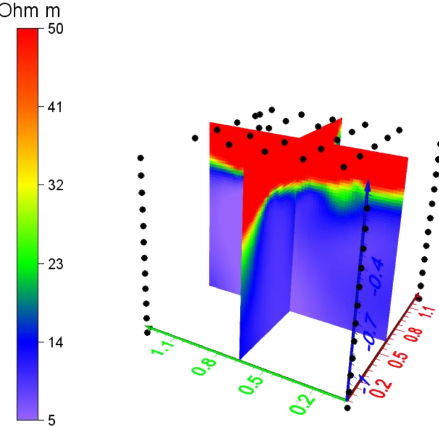
Figure 4. Cross sections of the ERT cube corresponding to the background acquisition of 2 October 2013, 11:00LT. Note the very strong difference in electrical resistivity between the top 40cm (above 50Ohm) and the rest of the domain. The resistivity distri- bution is essentially one-dimensional with depth, with very limited horizontal